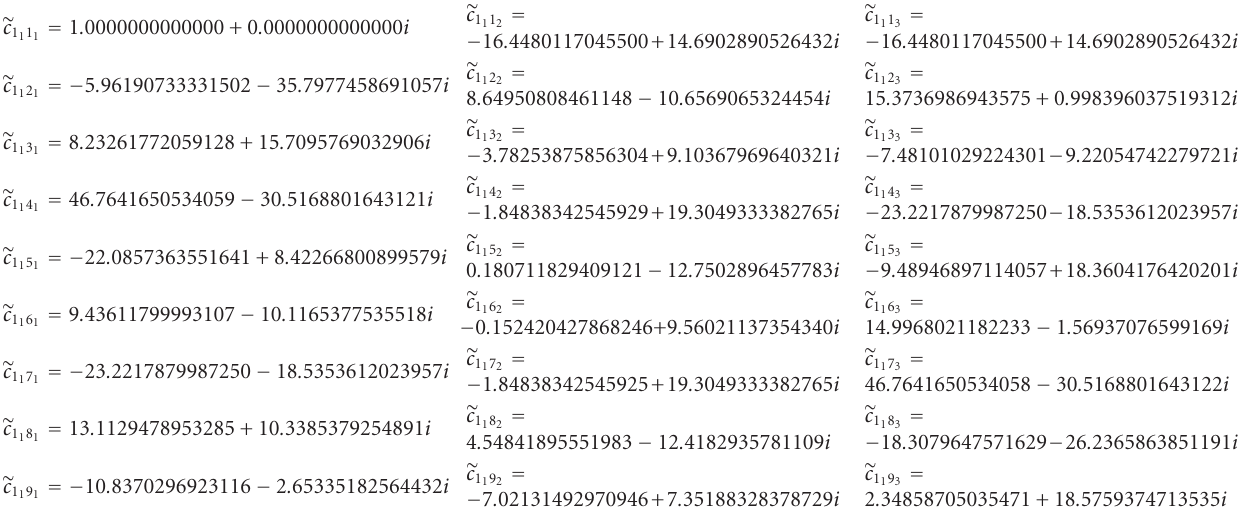
Table 2: Values of estimated compensation matrix using the proposed